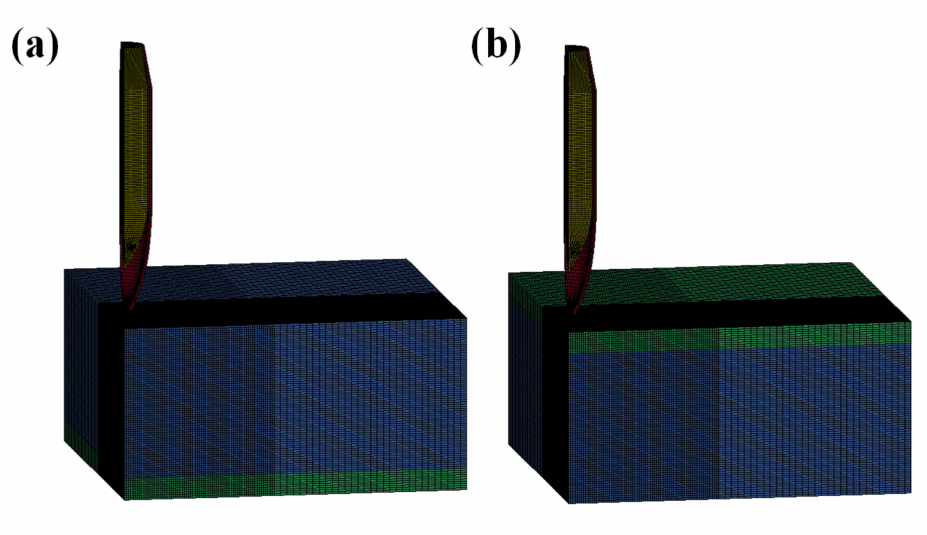
Figure 3. FEM model of the calculation: ( a ) Ti64 / CPTi and ( b ) CPTi /